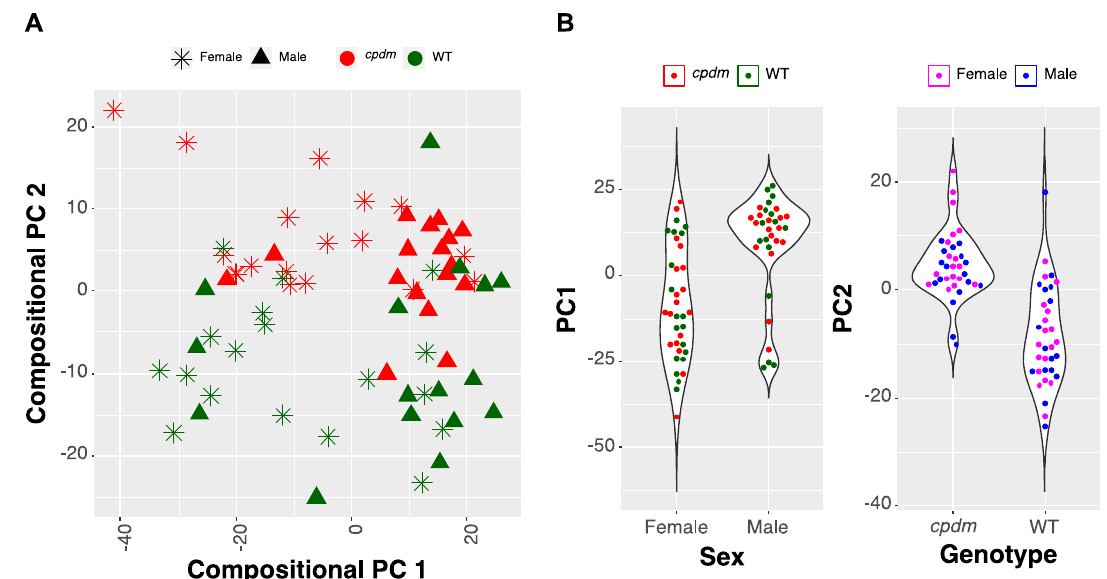
Figure 1. Monitored lipid ions in male and female cpdm and wild type (WT) epidermis by multiple reaction monitoring (MRM) scans in positive ion mode. Discrimination of the sex, as well as the genotypes of WT and cpdm mice (including non-lesional samples), was observed by compositional principal components (CPC) projection. ( A ) score plot of CPC analysis. ( B ) violin plots representing the separation of samples by sex and genotype. CPC 1 explained 30.2% of the variability of the data separating the samples by sex. CPC 2 explained 22.4% of the variance and was aligned with the genotype.